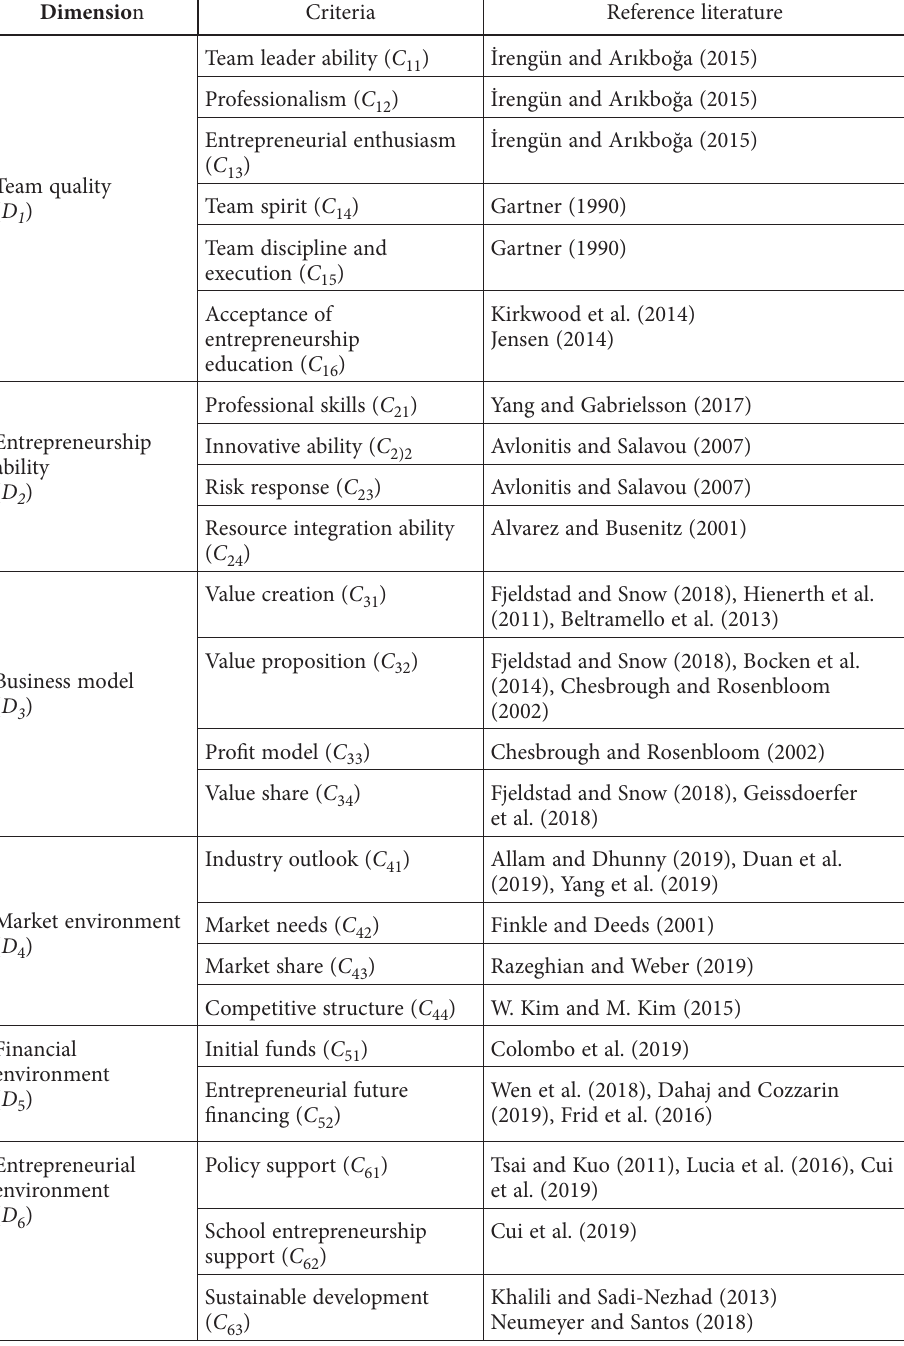
Table 1. The references of the dimension’s